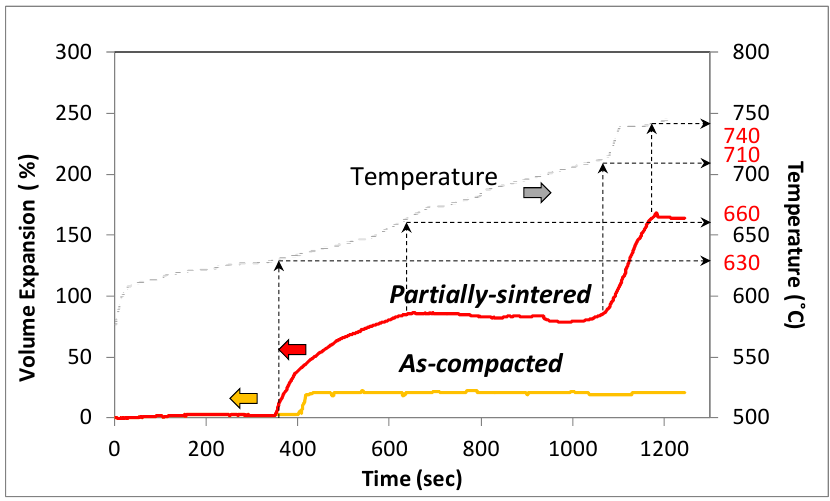
Figure 1. Foaming behavior of Al foam containing 15 wt.% Ni (Al–15Ni) with 10 wt.% dolomite precursors in the as-compacted and partially sintered states.